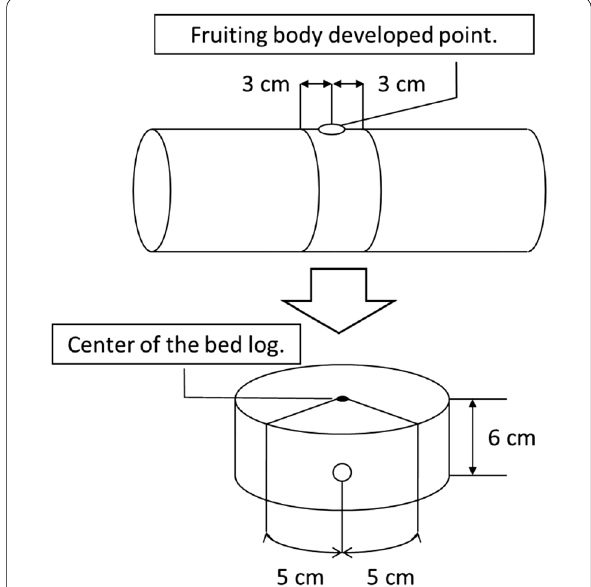
Fig. 1 Sampling method for analyzing Cs concentration in bed log at the point where fruiting body